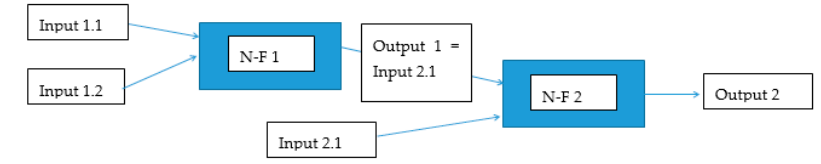
Figure 2. Model scheme using sequential aggregation of inputs.